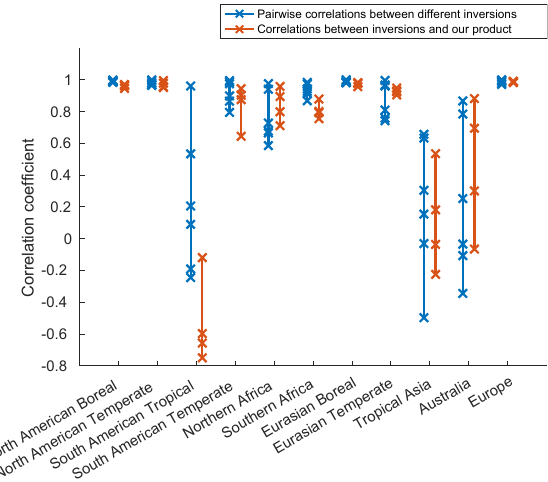
Figure 16. Distributions of correlation coefficients for the mean seasonal cycles in the 11 TransCom regions comparing either indi- vidual ensemble members from the set of atmospheric inversions or each ensemble member with our upscaled NEE